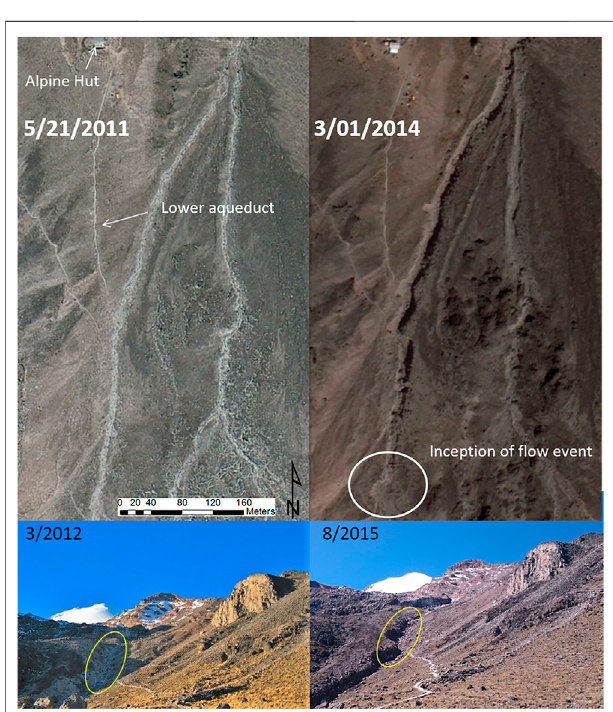
FIGURE 7 | Multi-date satellite images of the proglacial ramp and excised channel above Alpine Hut (visible at top of image frames at 4,250 m). Lower edge of image frames is at elevation 4,490 m. Signi fi cant widening and deepening is observed after 2012 event (here 2011 and 2014 imagery). Lower photos (3/2012 and 8/2015) show clearly the before and after channel